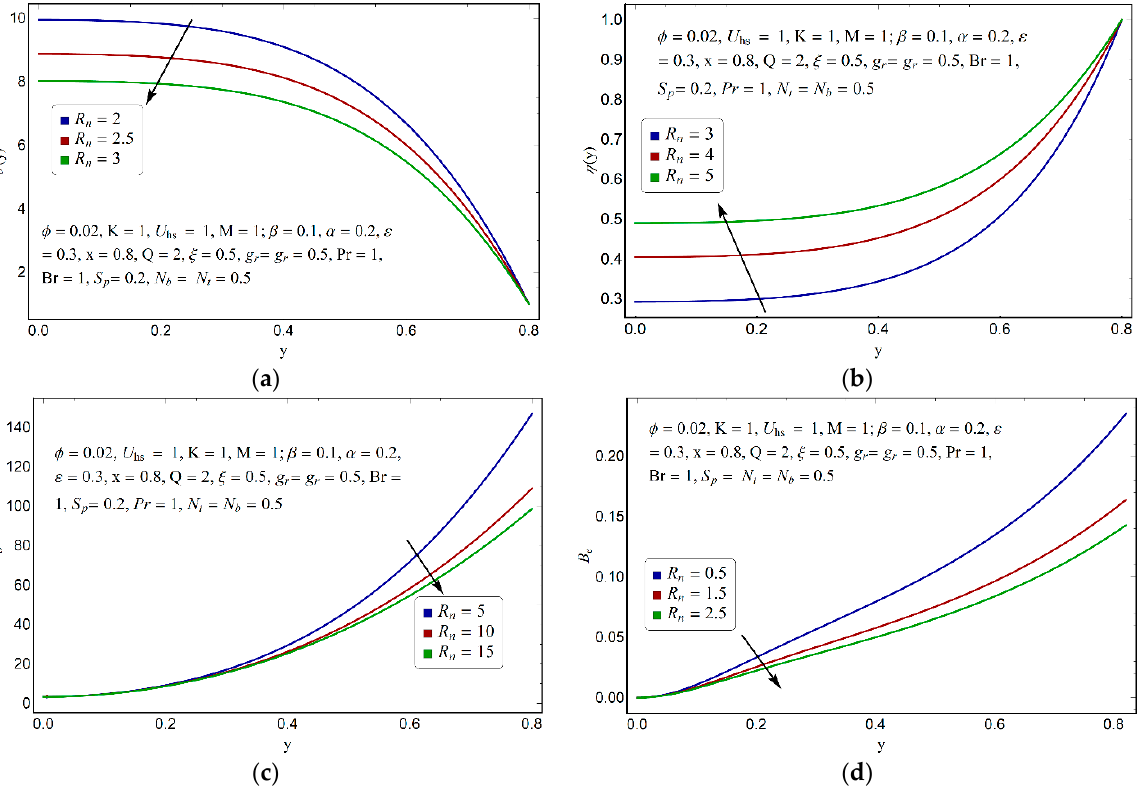
Figure 6. Impact of R n on ( a ) the temperature profile, ( b ) the mass concentration, ( c ) the entropy number, and ( d ) the Bejan number.